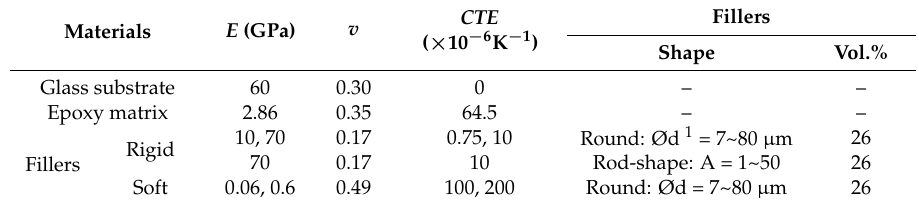
Figure 2. Model of epoxy composite coatings on glass substrate with an interfacial pre-crack. The epoxy matrix is modified with ( a ) round and ( b ) rod-shape fillers. Table 2. Material properties of epoxy, fillers and substrate for thermal stress simulation.